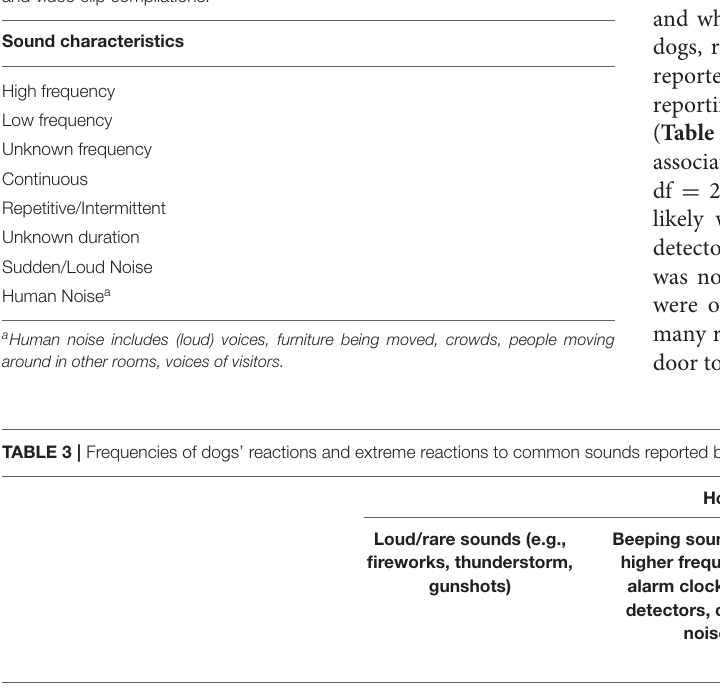
TABLE 2 | Primary characteristics of the household sounds audible in the videos and video clip